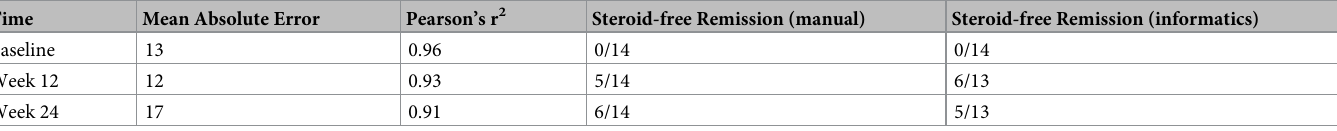
Table 1. Comparison of total CDAI as computed using CDAI elements ascertained informatically vs manually. All results correspond to the results of manual abstraction by one chart reviewer (45